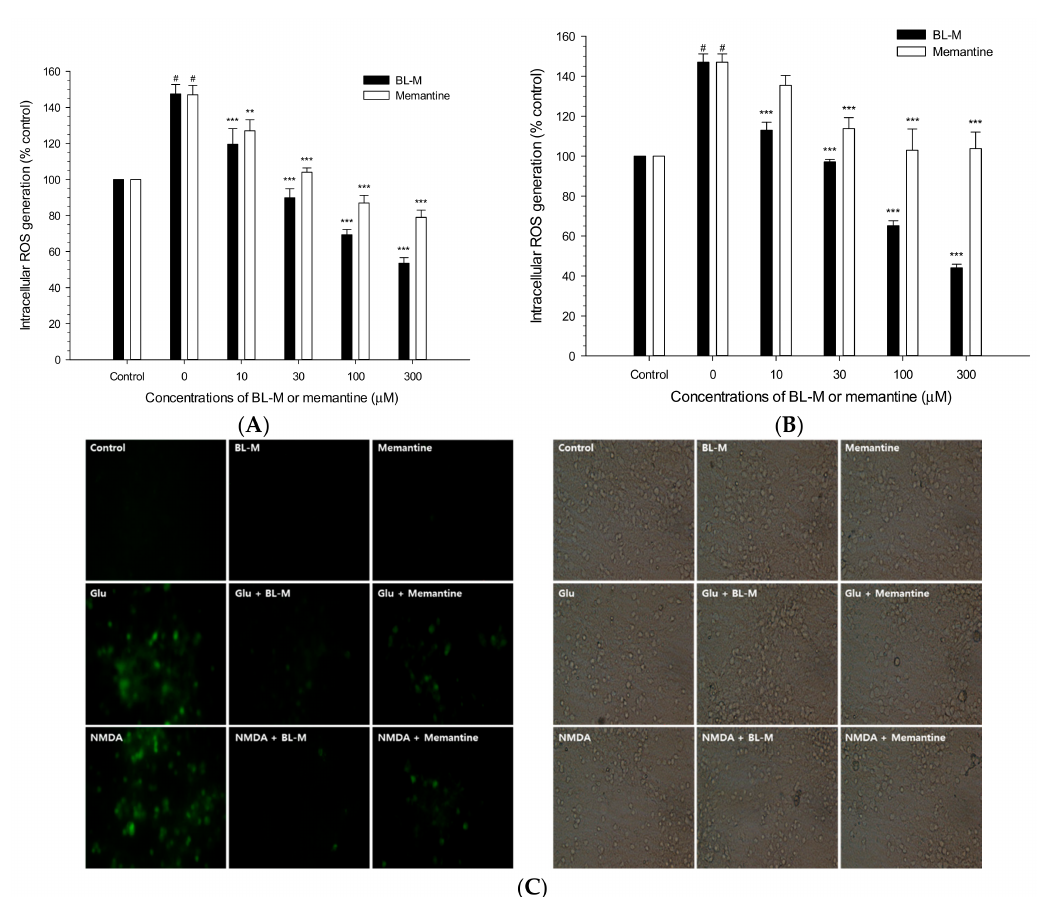
Figure 3. Inhibition by BL-M or memantine of Glu- or NMDA-induced intracellular ROS generation in primary cultured rat cortical cells. The cultured cells (10–11 days in vitro ) were incubated with 10 µ M DCFH-DA for 30 min and exposed to 100 µ M Glu ( A ) or 300 µ M NMDA ( B ) in the absence or presence of the indicated concentrations of BL-M or memantine, as described in the Section 4. The levels of intracellular ROS were measured at 2 h after the exposure to the respective insults, and expressed as % of control-treated cells. (# p < 0.001 vs. control; ** p < 0.01, *** p < 0.001 vs. Glu- or NMDA-treated cells, respectively). Each data represents the mean ± S.E.M. from at least three independent experiments. Representative epifluorescent (left) and bright-field (right) images of cells exposed to Glu or NMDA with or without BL-M or memantine at 10 µ M are shown ( C